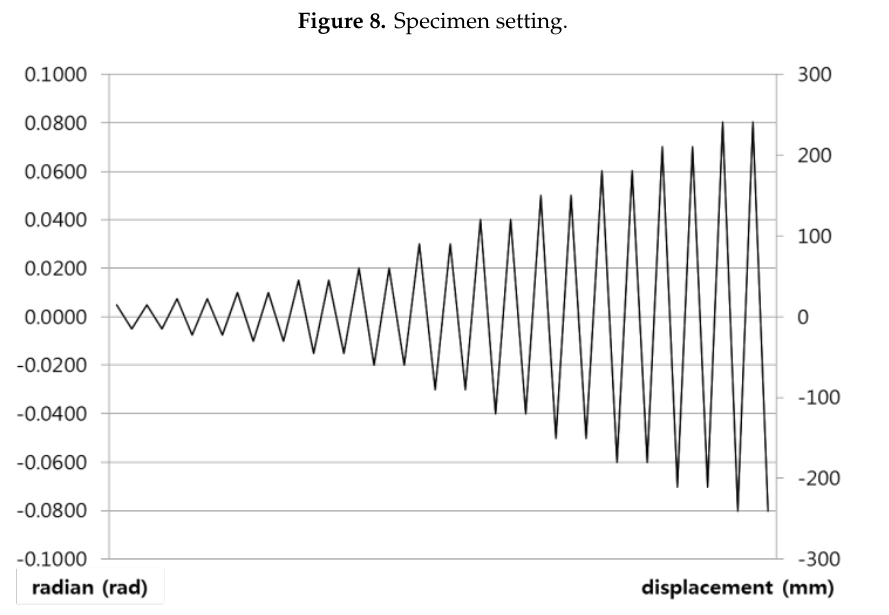
Figure 9. Cyclic loading applied to the specimens.